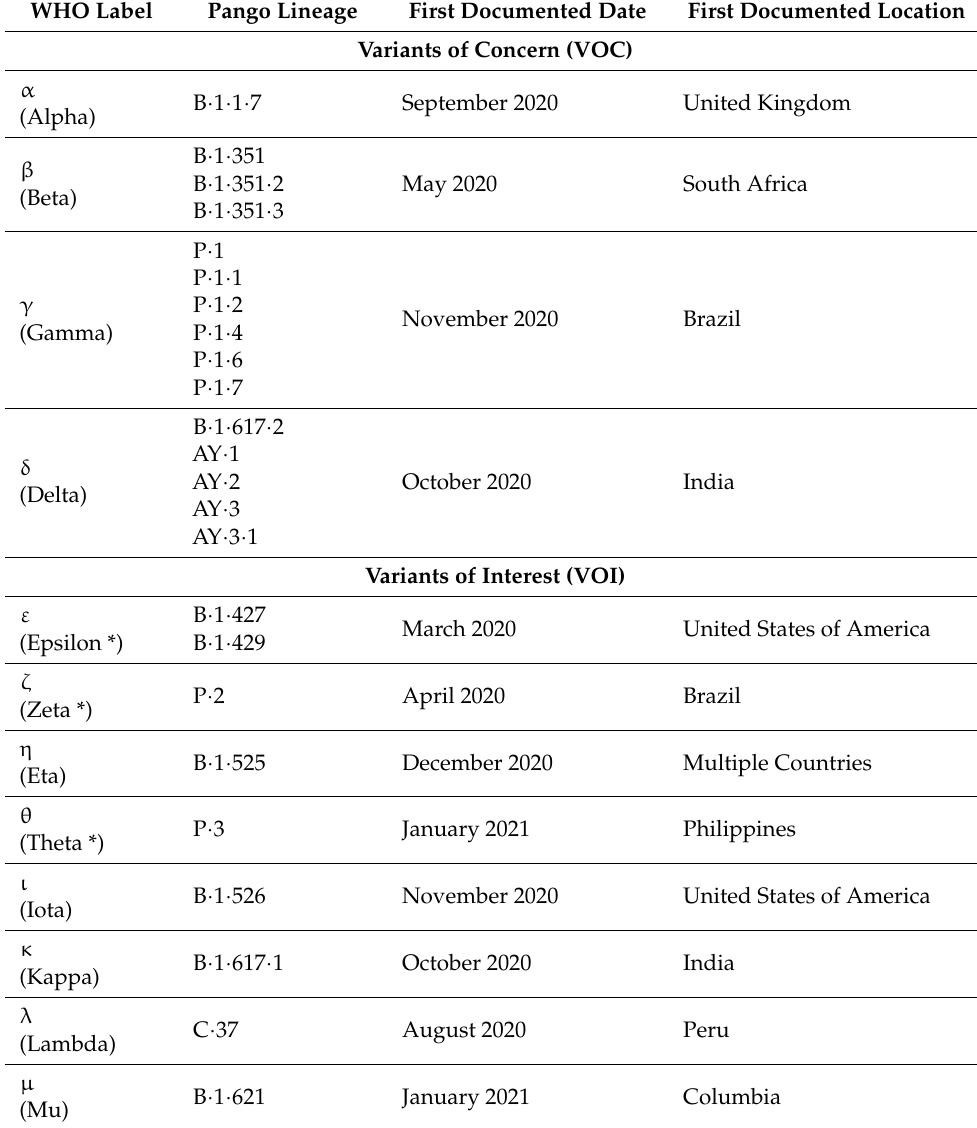
Table 1. The classification of SARS-CoV-2 variants as of 31 August 2021. WHO